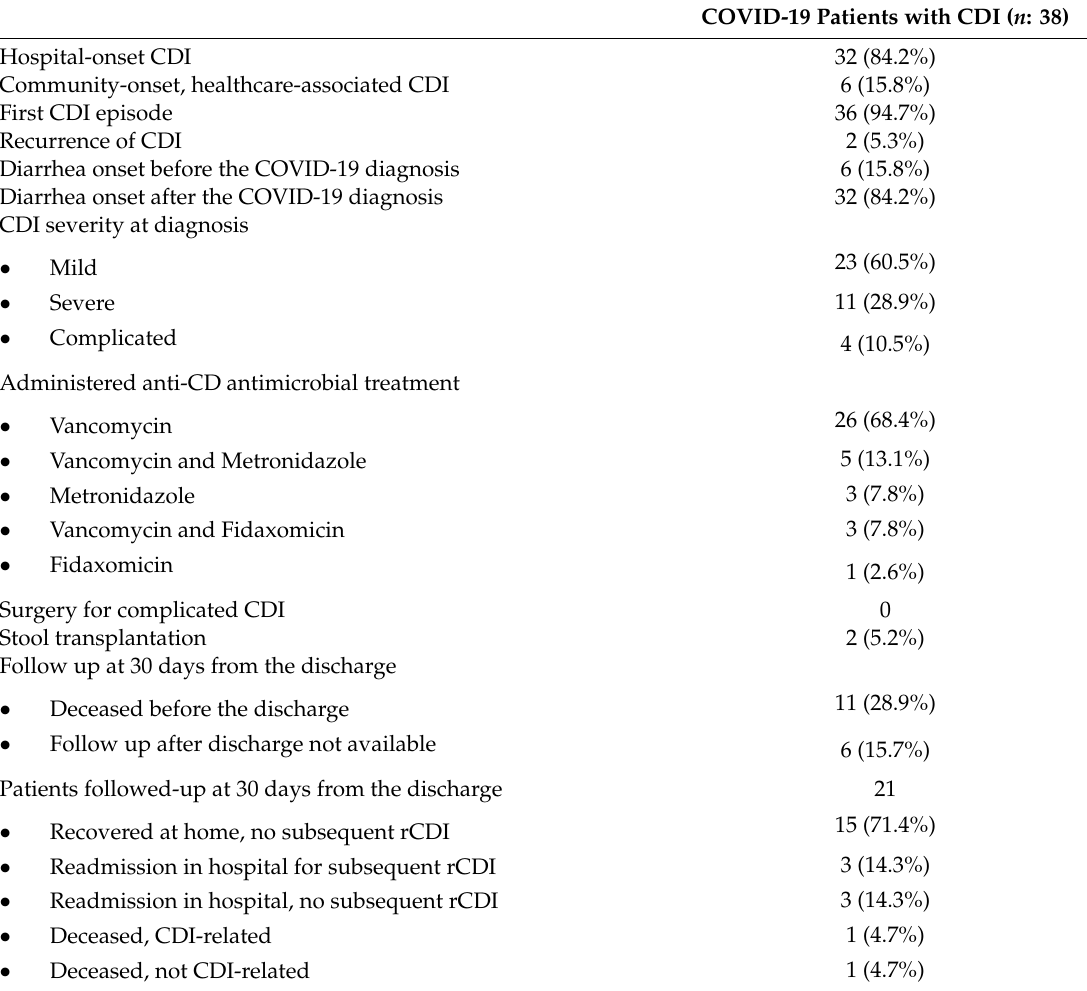
Table 3. Clostridioides di ffi cile infection characteristics, severity, management, outcome and follow-up of the 38 COVID-19 patients with CDI included in the study. CDI: Clostridioides di ffi cile infection. rCDI: recurrent CDI